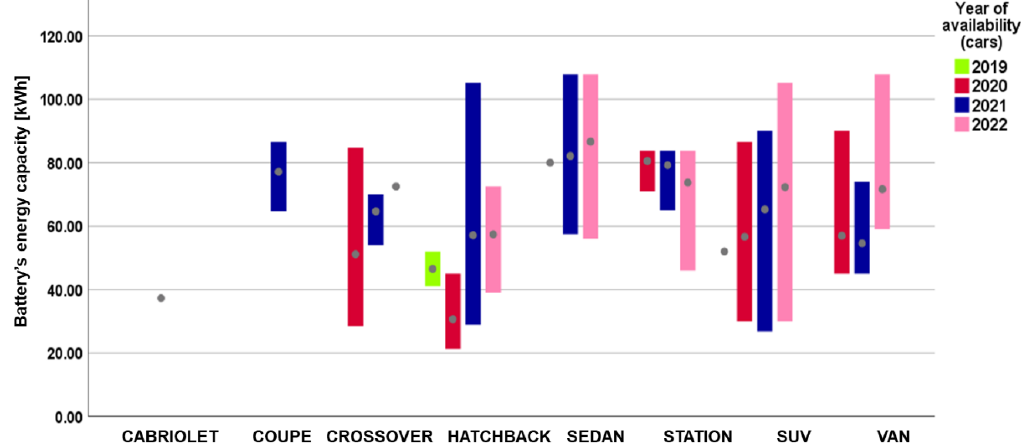
Figure 16. Range bar variation (min, max, mean) representation of battery’s energetic capacity vs. type of cars.